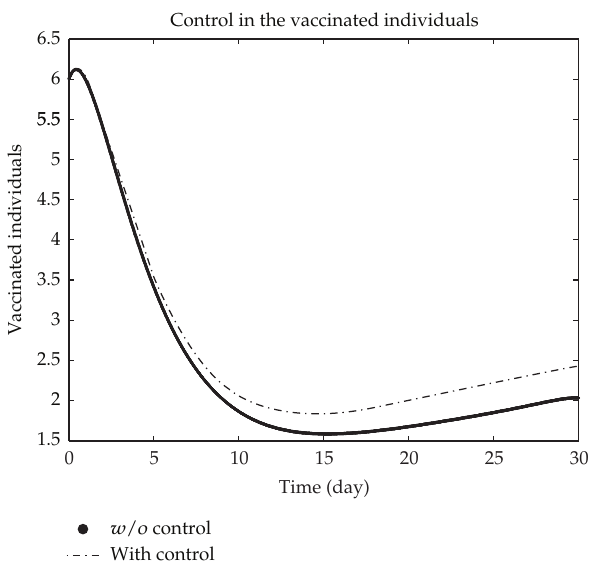
Figure 2: The plot represents the population of vaccinated class with and without